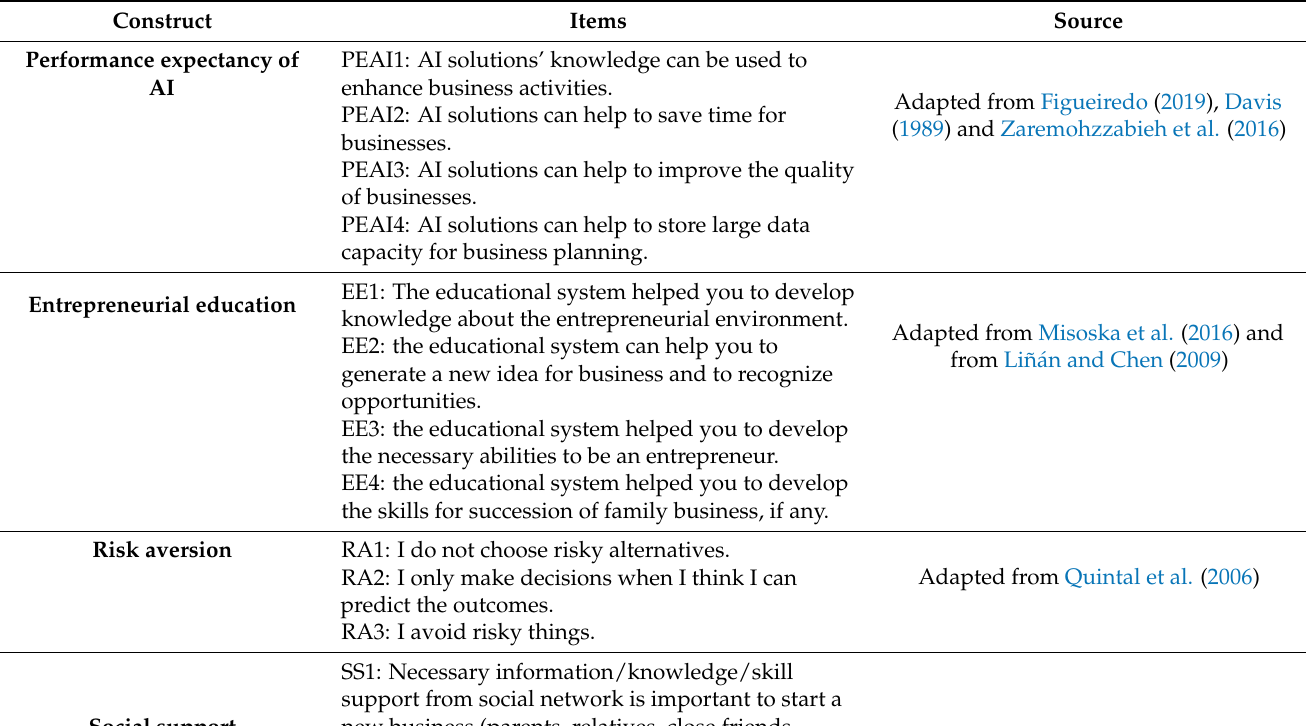
Table A1. Measurement scales